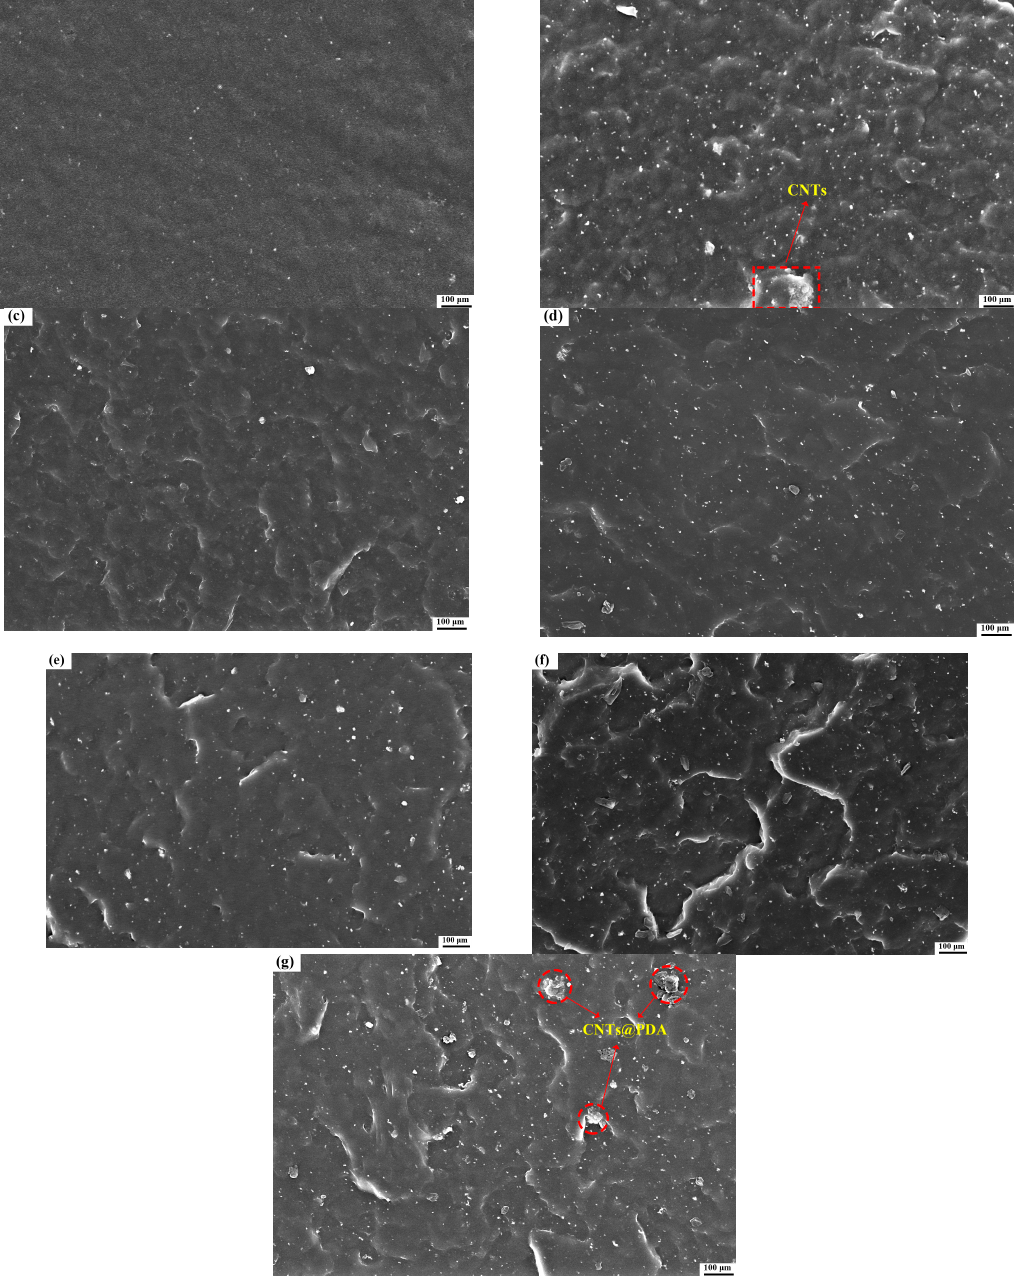
Figure 12. SEM images of fracture sections of TPI composites: ( a ) Neat TPI; ( b ) TPI with 0.6 phr CNTs; ( c ) TPI with 0.6 phr CNTs@PDA; ( d ) TPI with 1.2 phr CNTs@PDA; ( e ) TPI with 1.8 phr CNTs@PDA; ( f ) TPI with 2.4 phr CNTs@PDA; and ( g ) TPI with 3.0 phr CNTs@PDA.